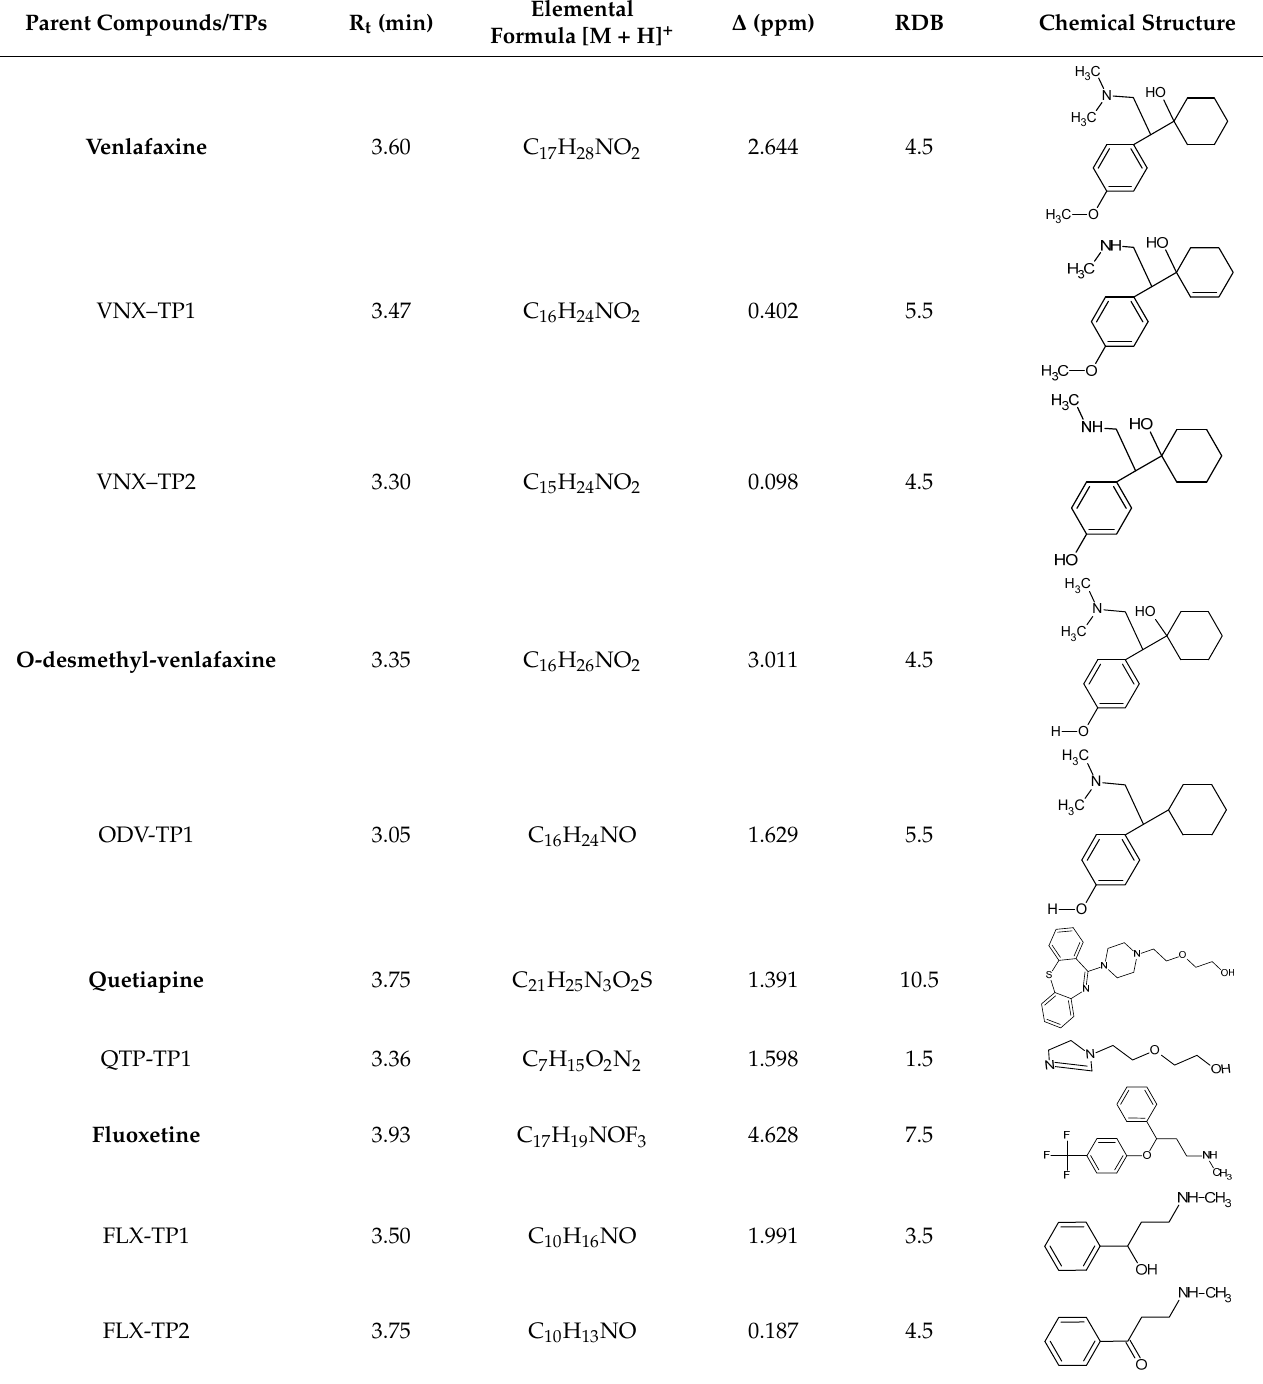
Table 4. Retention time (R t ), elemental formula, mass error, and double-bond–ring-equivalent number (RDB) of parent compounds and transformation products (TPs) identified during the photocatalytic treatment by UHPLC-Orbitrap MS.